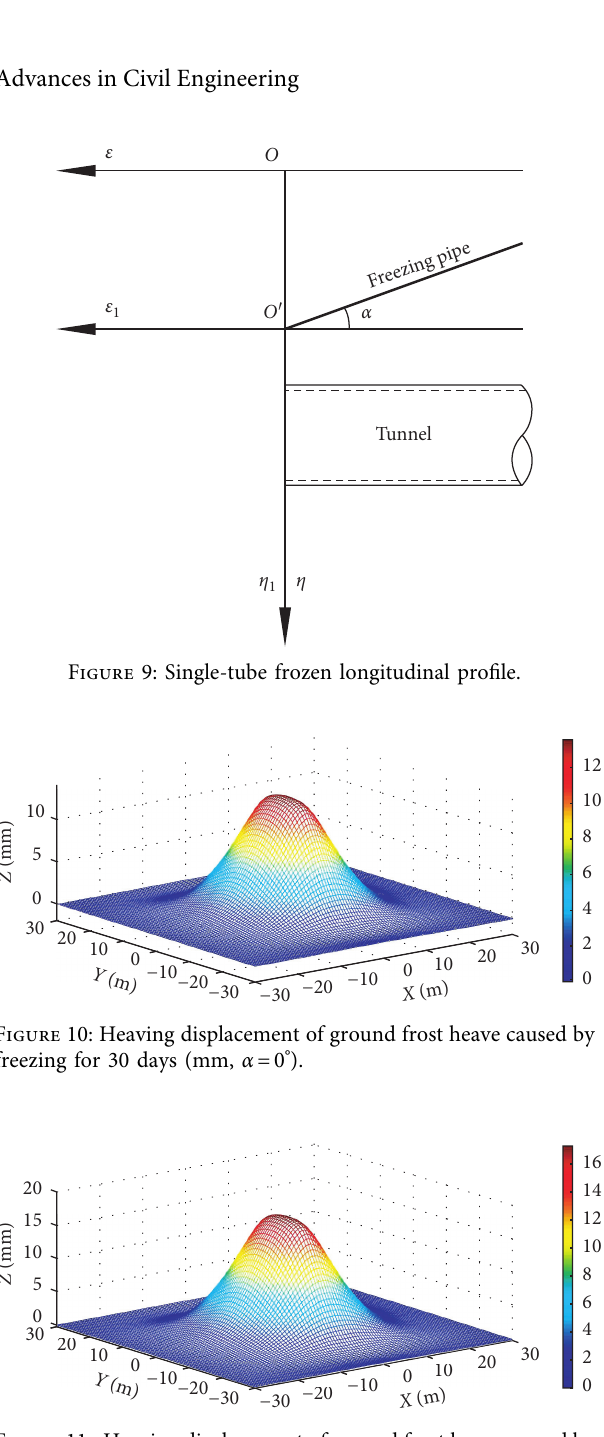
Figure 11: Heaving displacement of ground frost heave caused by freezing for 45 days (mm, α � 0 ° ).